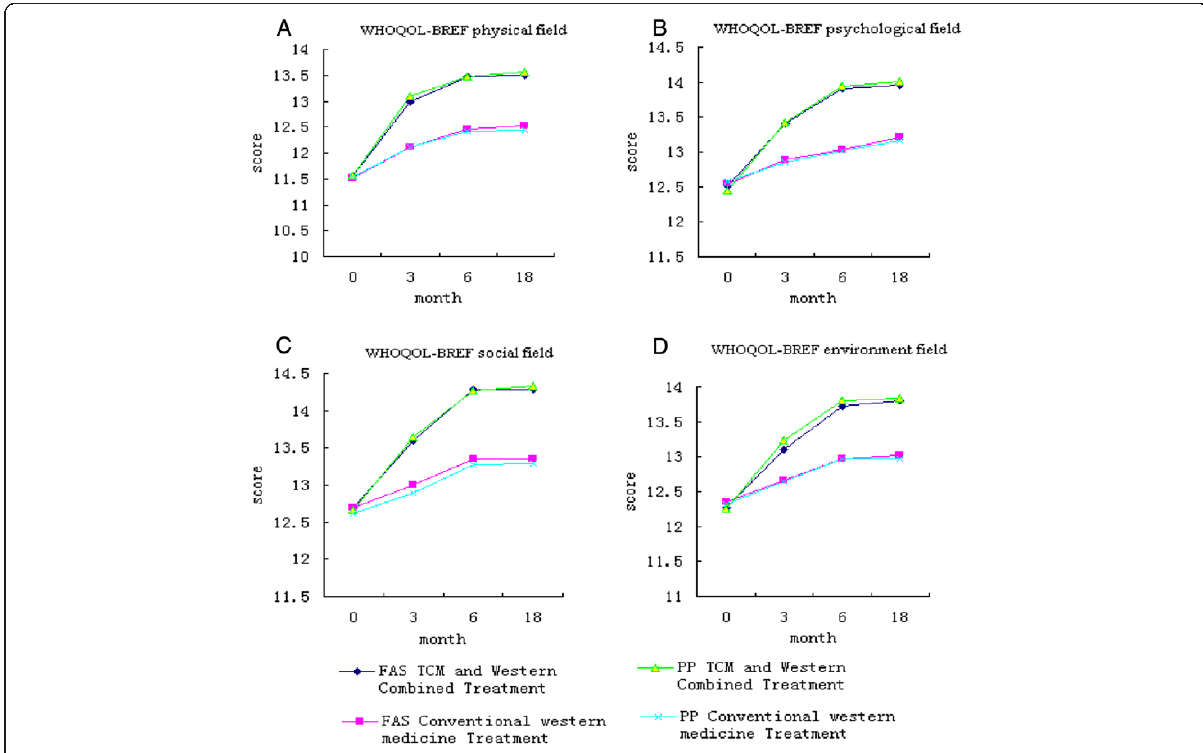
Figure 3 Comparison of the results of WHOQOL-BREF physical field, psychological field, social field, and environment